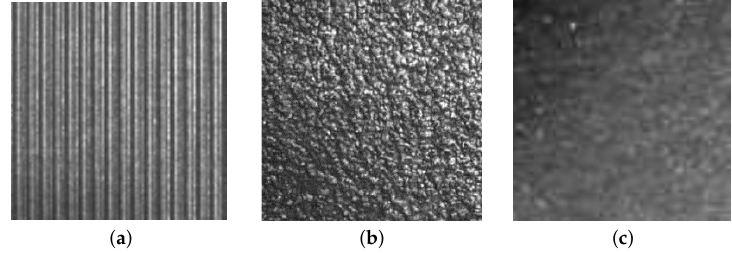
Homogeneous and inhomogeneous textures: ( a ) homogeneous structural texture; ( b ) homogeneous statistical texture; ( c ) inhomogeneous